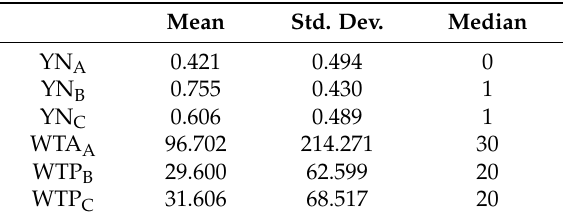
Table 2. Summary statistics of the dependent variables.